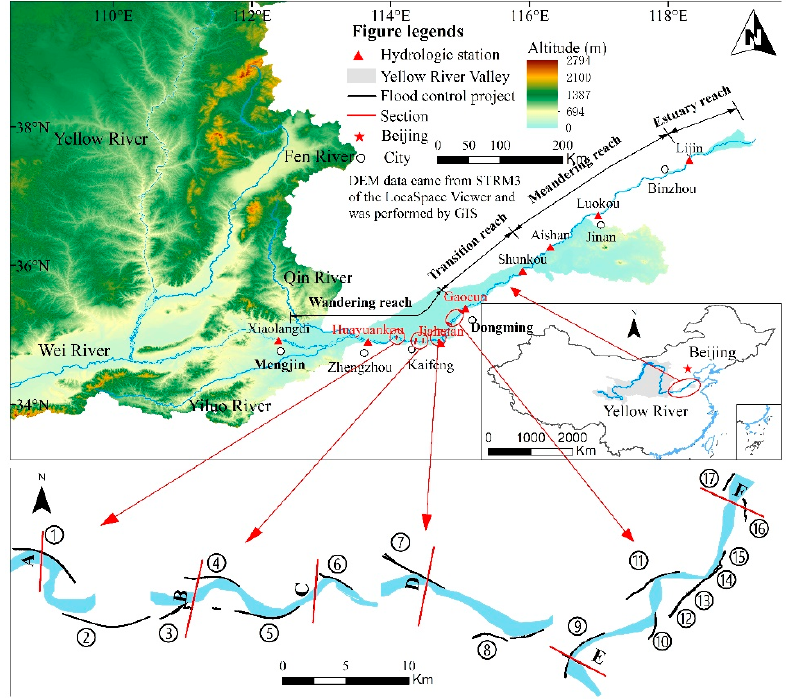
Figure 7. Wandering reach of the lower Yellow River (Heishi–Hedao): ① Sanguanmiao control pro-